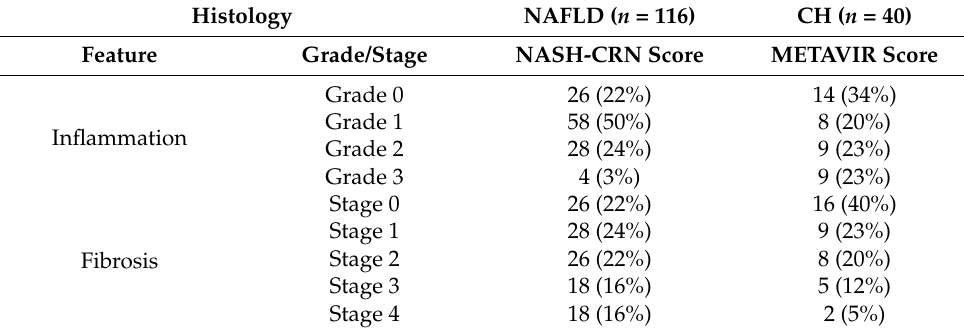
Table 2. Histopathological characteristic distribution of the study